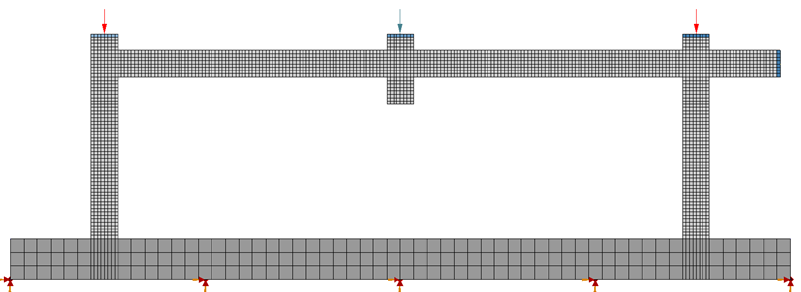
Figure 1. Numerical model for reinforced concrete frames. The arrows on top of the frame denote vertical loads, and those at the bottom represent vertical and horizontal restraints.